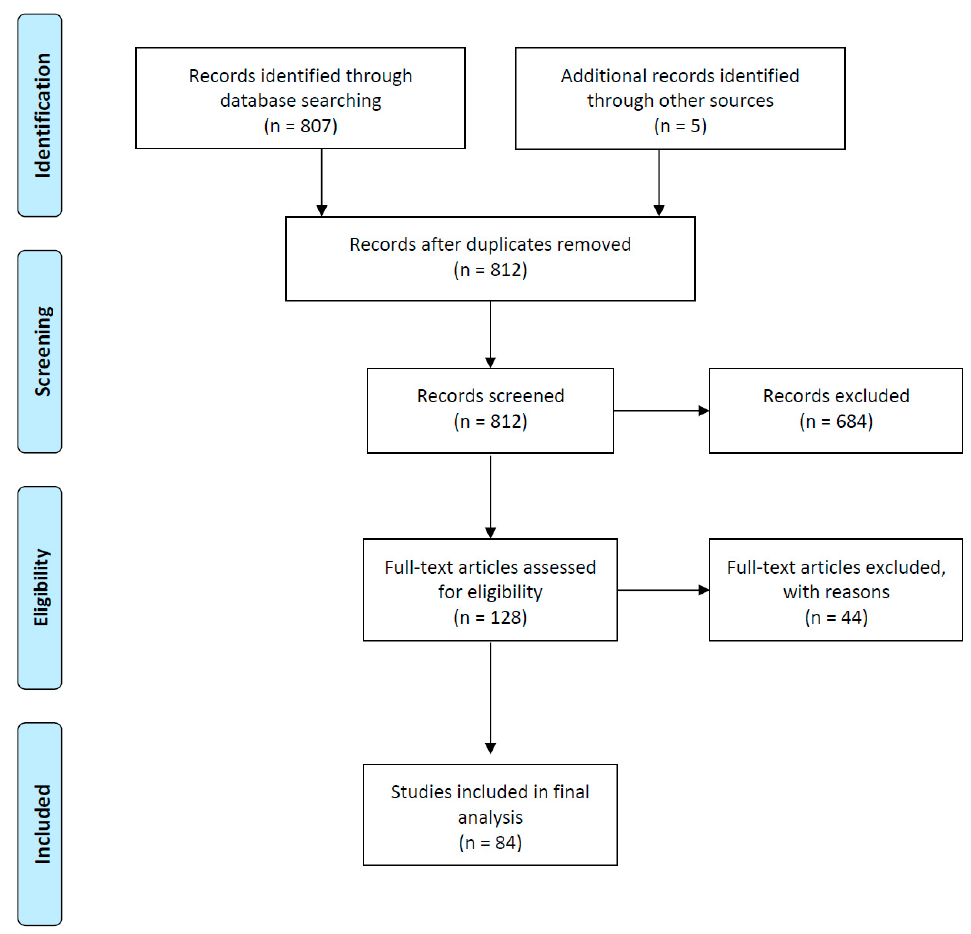
Figure 1. Flow diagram representing a summary of the conducted methodology for this review.